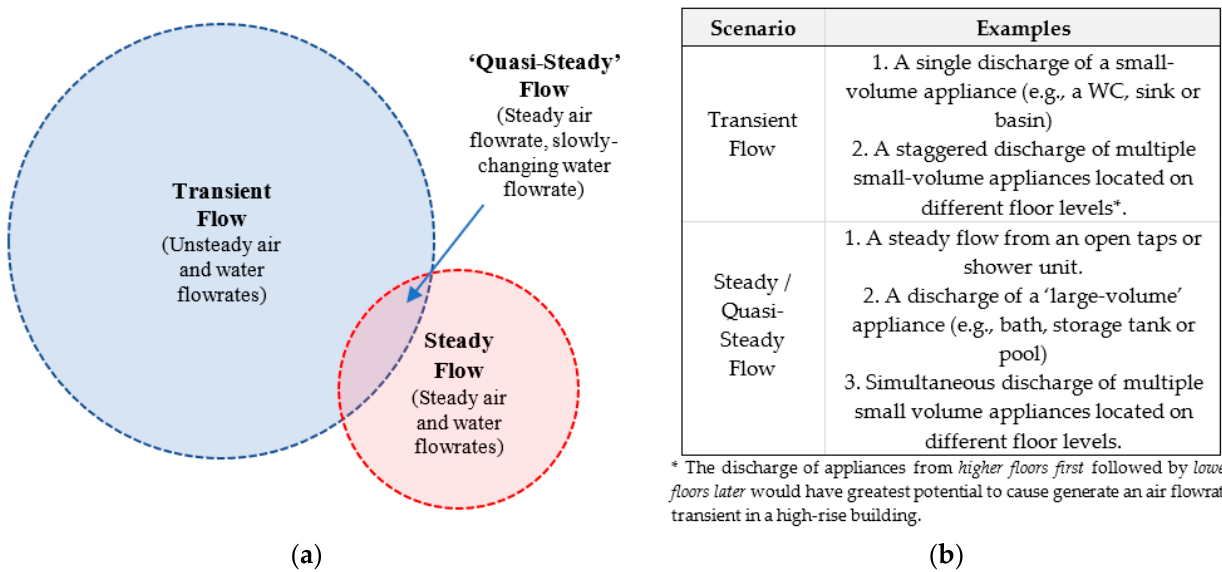
Figure 1. Simulation software for design of high-rise WDSs. ( a ) Solver domain ( b ) Examples of discharge events which lie within the solver domain.